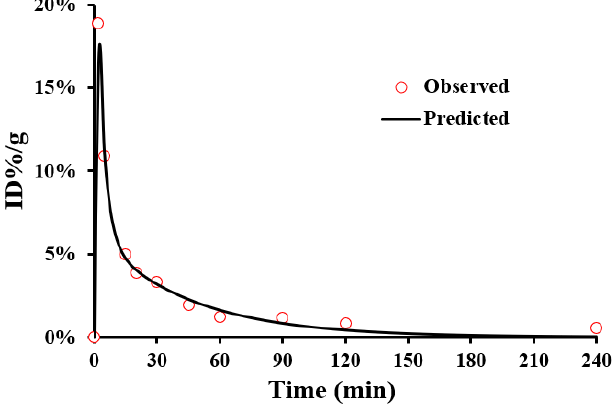
Figure 7. The blood drug concentration (%ID/g)-time curve for 99m Tc-HYNIC-ADH-1 in C57/BL6 mice until 240 min after injection.